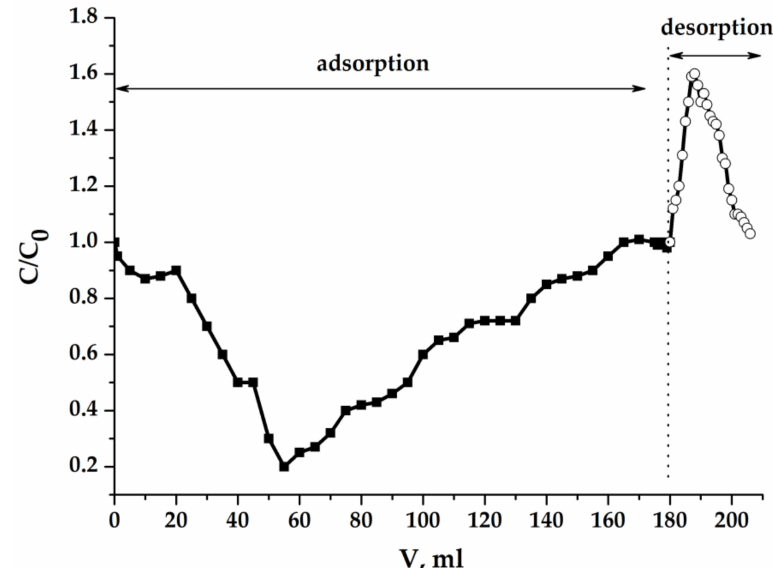
Figure11. NaClconcentrationinthee ffl uentindynamicprocess: C 0 (NaCl) = 0.1g / dm 3 (0.0717eqv / dm 3 ); U = 1.2 V; porous electrode (cm): 3 × 3 × 0.5; electrode gap: 0.5 cm; flow rate: 0.42 cm 3 /